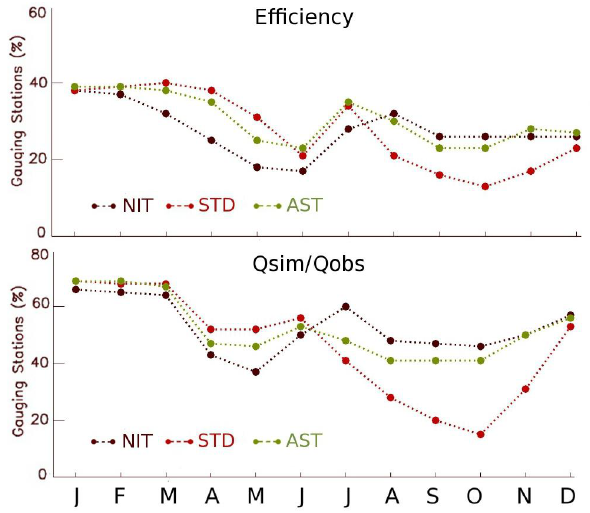
Fig. 8. Monthly percentage of river flow gauging stations presenting (top panel) an efficiency score greater than 0.5 and (bottom panel) a Q sim /Q obs ratio greater than 0.8 and smaller than 1.2, for NIT-, AST- and STD-TRIP simulations (black, green and red lines, re- spectively). These distributions are computed from a dense obser- vational network consisting of daily river discharges over the 1991– 2008 period, at the 150 gauging stations of the CNF area.